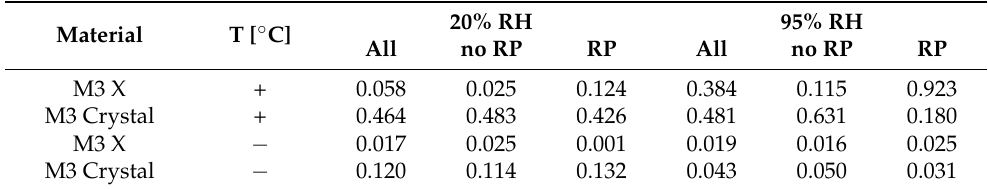
Table 7. Mean strain differences 1 × 10 − 3 (m/m) among the samples—between embedded ( w ) and attached ( z )